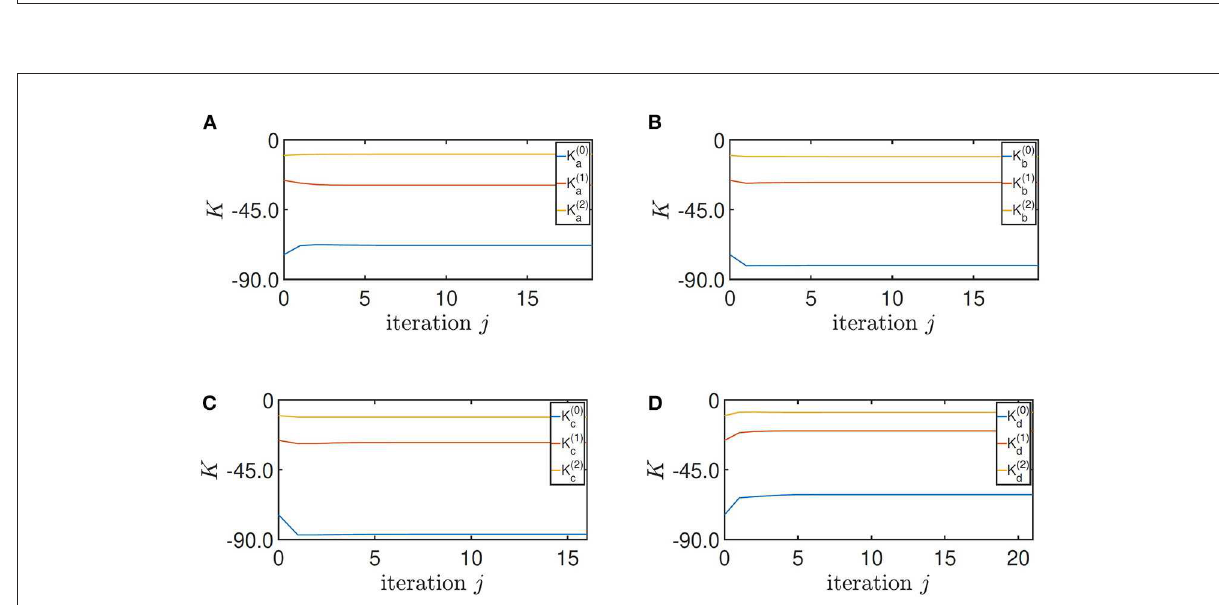
FIGURE7 Convergence of the feedback gain K . (A) Height = 0.33 m, (B) height = 0.5 m, (C) height = 0.5 m with the load, and (D) height = 0.5 m on the